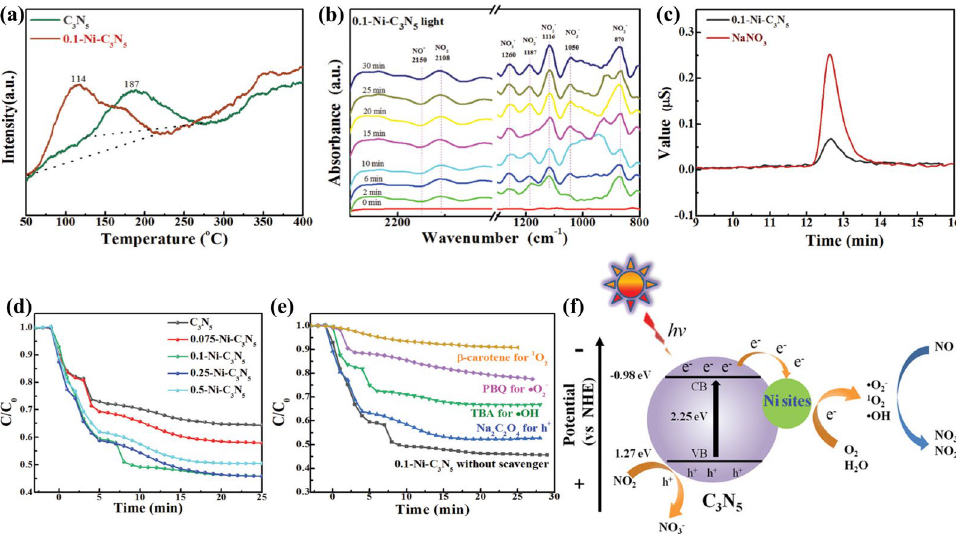
Figure 18. ( a ) O 2 -TPD spectra of C 3 N 5 and 0.1 − Ni − C 3 N 5 ; ( b ) In situ DRIFTS spectra of 0.1 − Ni − C 3 N 5